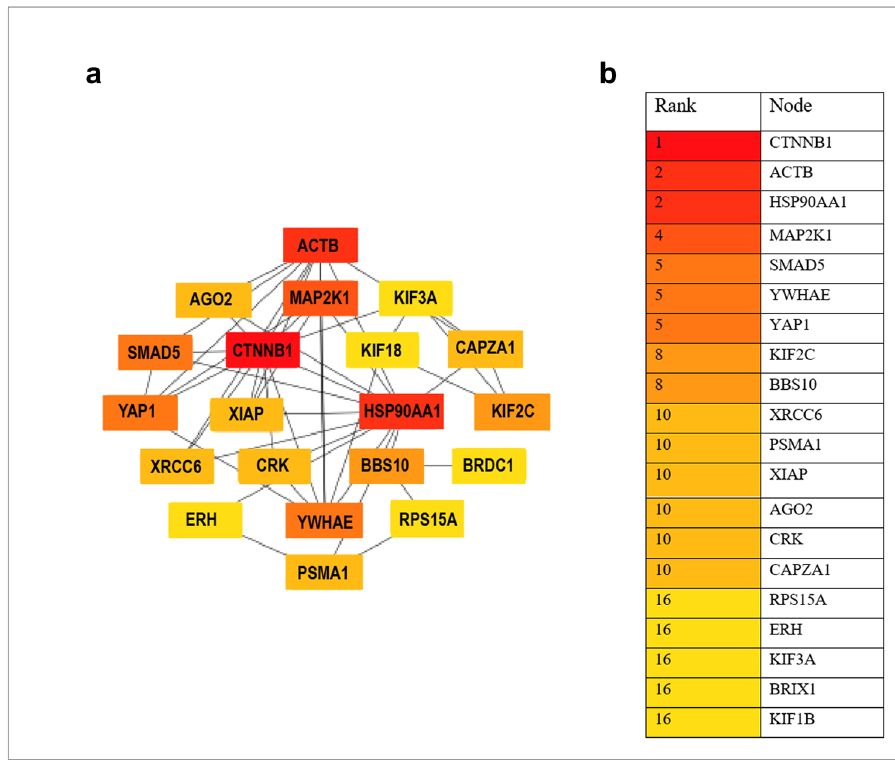
Figure 5. Hub genes among miR-548l target genes, ( a ) PPI network of the top 20 hub nodes targeted by miR548l. ( b ) Rank table for the top 20 hub nodes and their ranks based on degree algorithm. The darker red color, the higher the